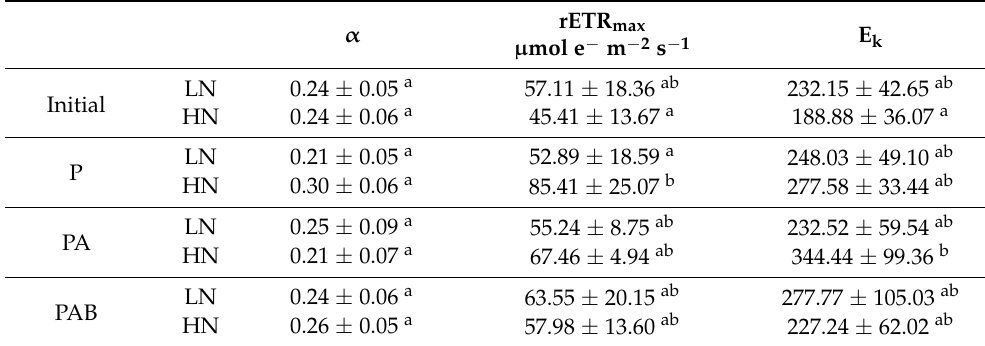
Table 1. Photosynthetic parameters of rapid light curve for Sargassum horneri cultured under different treatments. α is the electron transport efficiency, rETR max is the maximum relative electron transport rate, and E k is the minimum saturated irradiance. Different superscript letters indicate significant differences among different treatments (p <